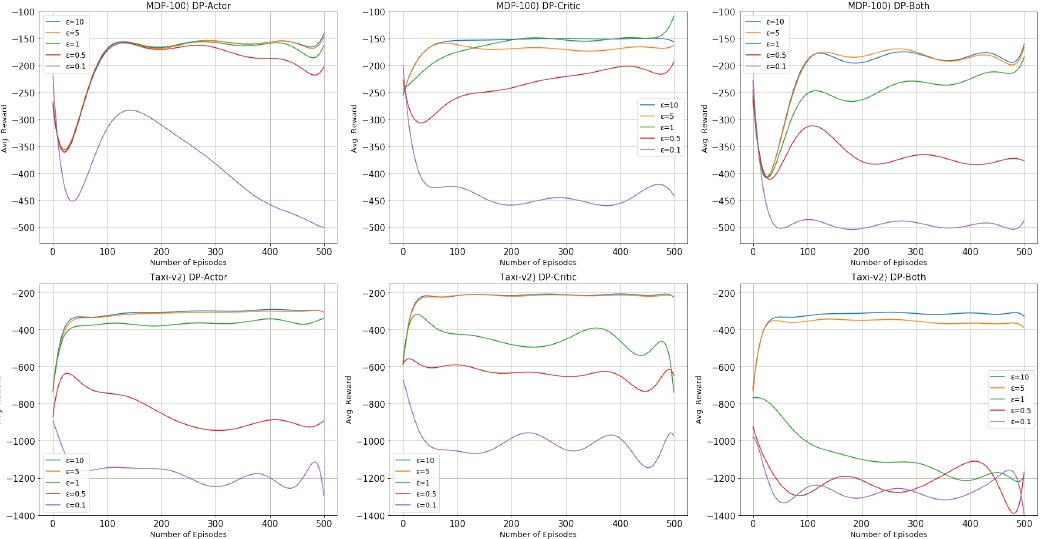
Figure 3. Learning curves according to changes of the privacy budget ( (cid:101) = { 10,5,1,0.5,0.1 } ) in synthetic examples (MDP-100, Taxi-v2). We fixed the optimal parameter set from each case and varied only the privacy budget ( (cid:101)